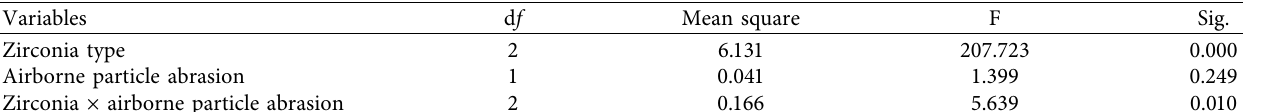
Table 2: The effect of the studied factors on the flexural strength (two-way ANOVA) ( P < 0.05).